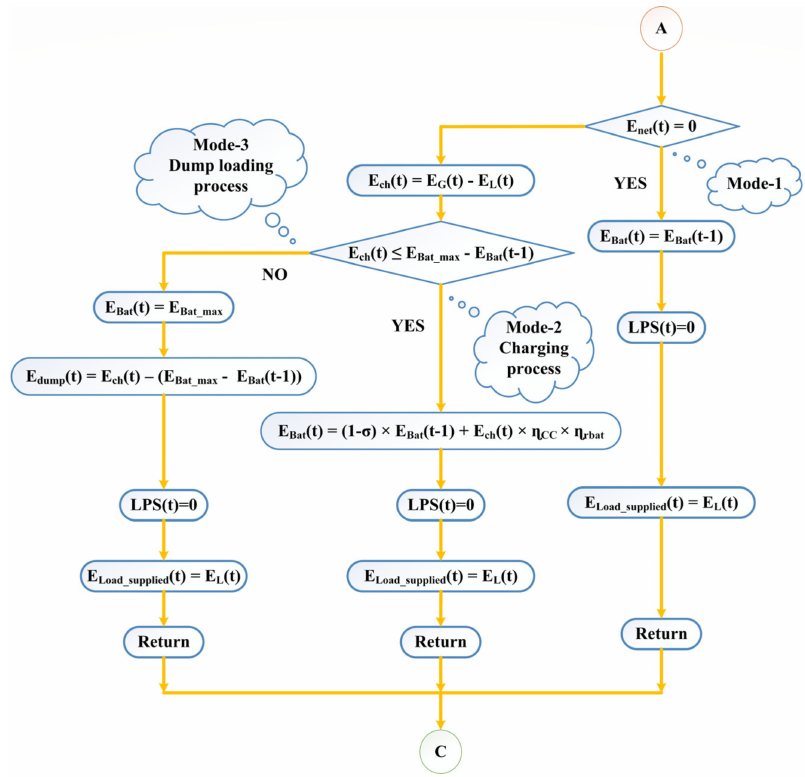
Figure 13. Flowchart of the EMS operating modes and acquisition of LPSP using LF and CC strategies.